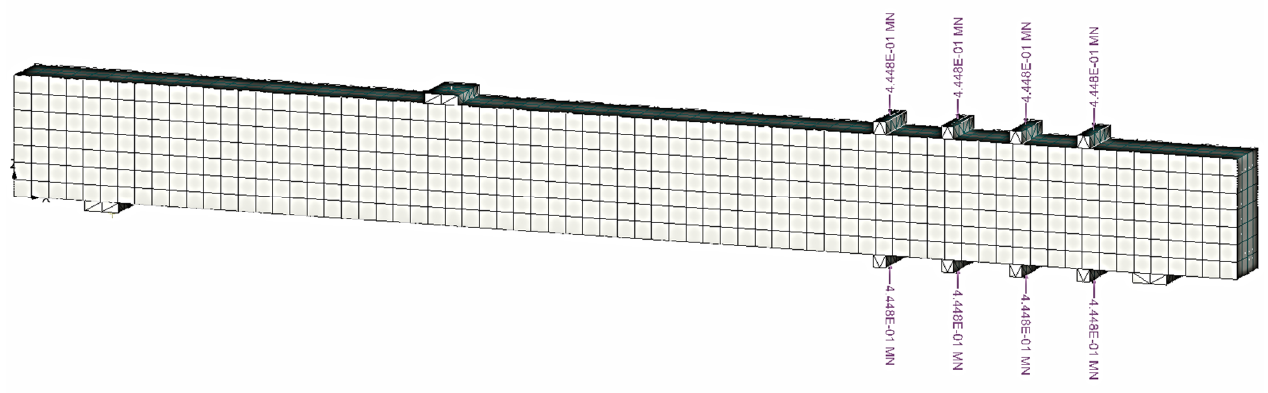
Figure 9. Finite element mesh and post-tensioning force.